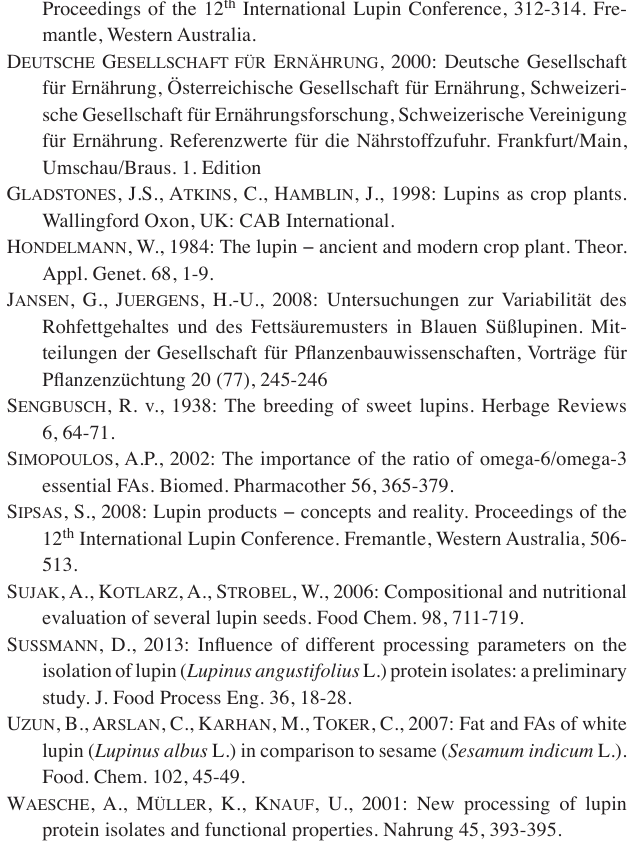
Fig. 1: Principal component biplot with scores represented by 12 trials and loadings represented by 5 FAs. The dots of the scores are labeled as follows: Bornhof (B), Dratow (D), Steinach (S) and Groß Lüsewitz (G) in the years 2010 (10), 2011 (11) and 2012 (12).